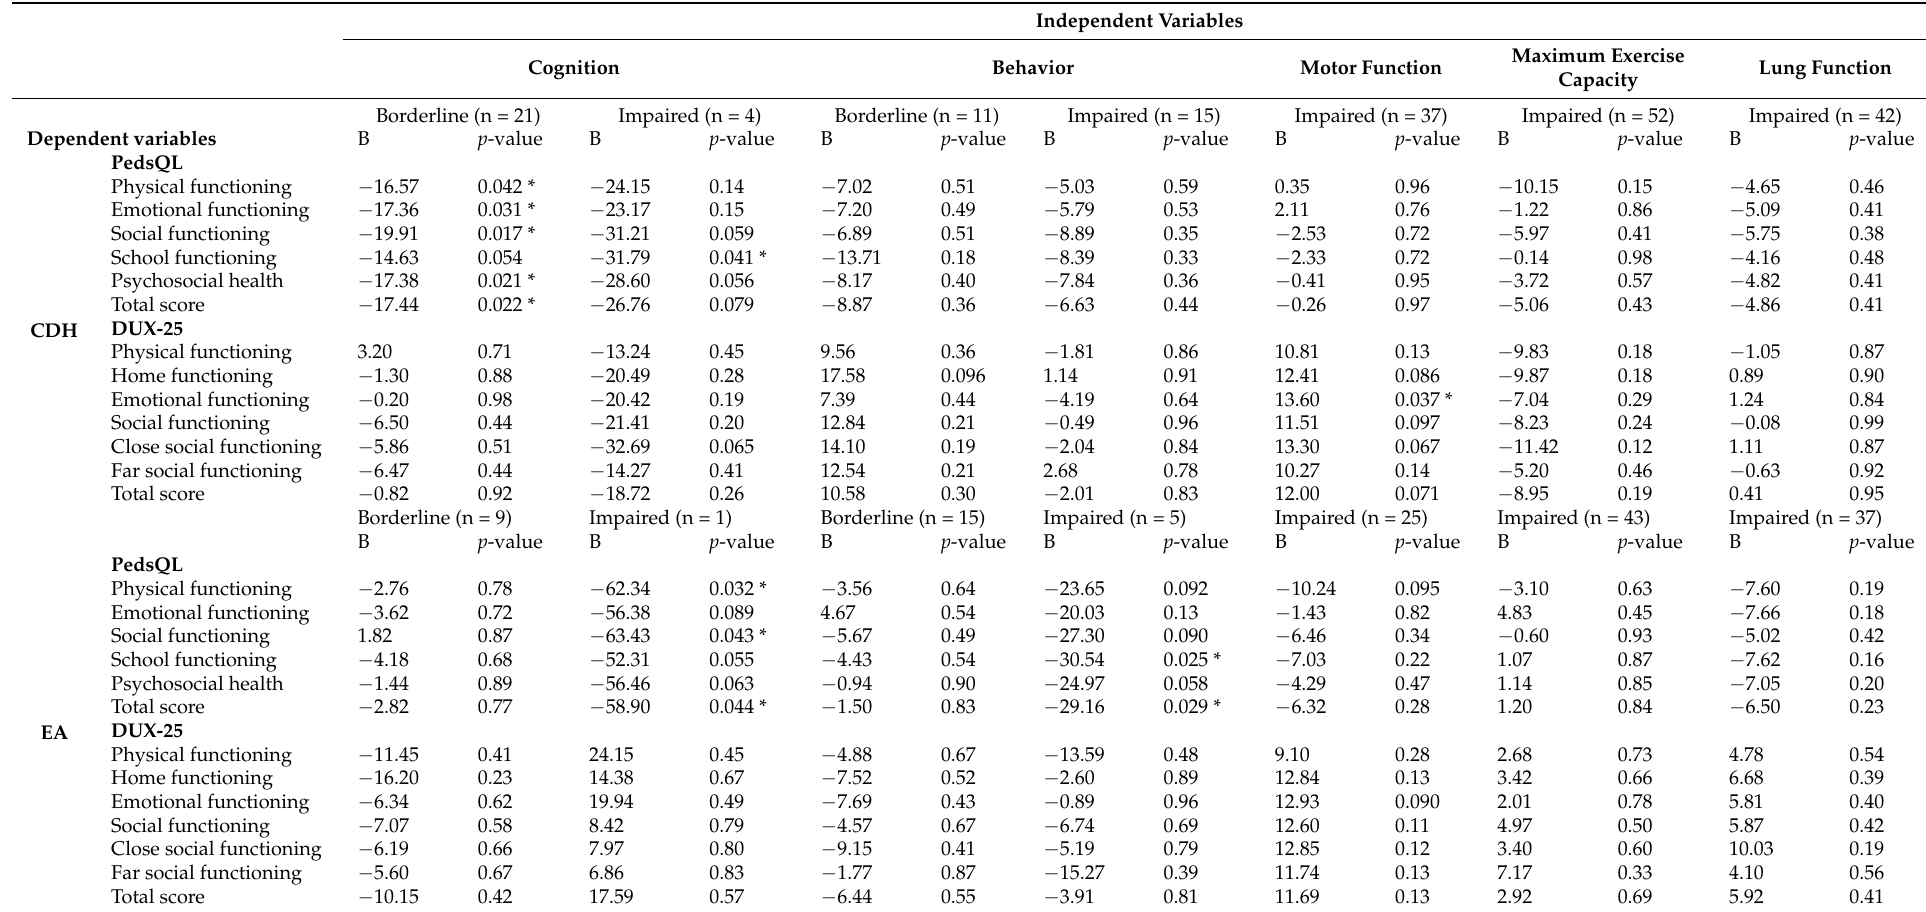
Table 3. Results of multiple linear regression analyses for PedsQL and DUX-25 scores and subscales of children with congenital diaphragmatic hernia (CDH, n = 114) and esophageal atresia (EA, n = 93). Asterisk (*) indicates significance ( p < 0.05). B = unstandardized